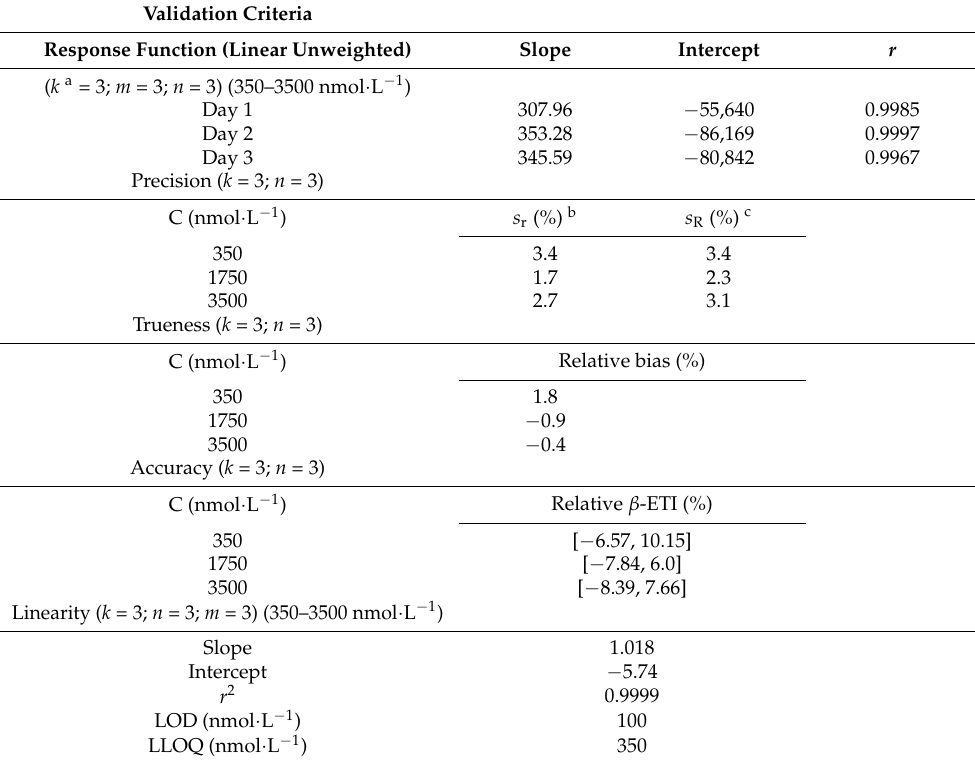
Table 2. Validation results for the quantitation of Colistin A in a pooled drug-free urine sample ( n = 6). Validation